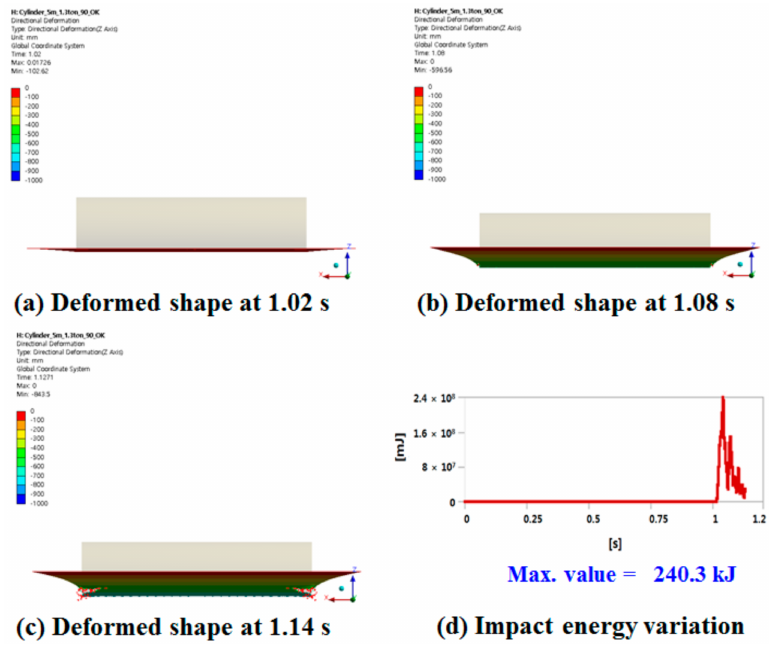
Figure 26. Simulation results (case 3, 90 ◦